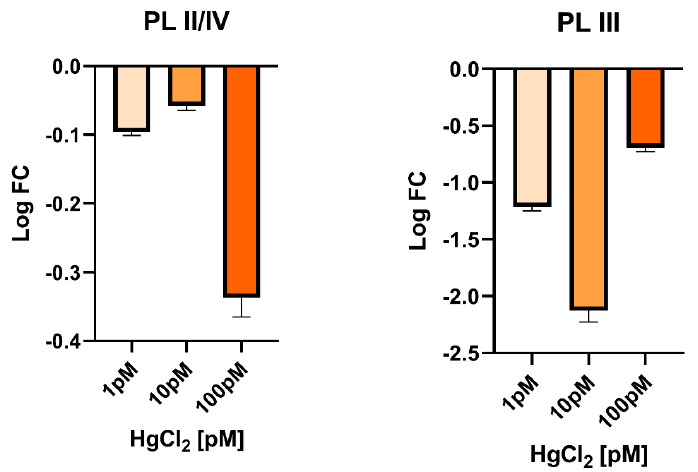
Figure 4. RT-qPCR expression analysis of M. galloprovincialis gonadal PLIII and PLII/IV genes. In the figure, the change in gene expression is reported under the three HgCl 2 exposure conditions compared to the control condition (nonexposed mussels: CTR). Expression was determined with respect to the GAPDH housekeeping gene. Values are presented as mean ± S.D. ( n =